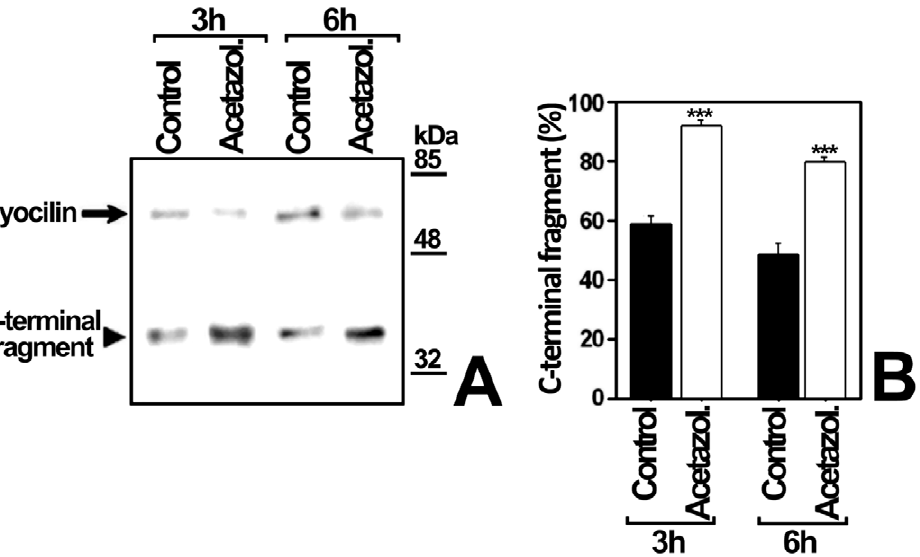
Figure 8. Effect of carbonic anhydrase inhibition on myocilin proteolytic processing. (A) HEK-293T cells (500000 cells/plate) were transfected with a cDNA construct encoding myocilin-myc. After transfection cells were cultured in bicarbonate-free HEPES buffered medium (75 mM, pH 7.1) for 3 or 6 h in the presence of acetazolamide (0.25 mM). Extracellular recombinant myocilin was analyzed by 10% polyacrylamide SDS-PAGE and Western blot using an anti-myc monoclonal antibody. Equal amount of total protein was loaded into each well. (B) Quantitation by densitometry of the C-terminal fragment detected in A. Values represent the proportion of this myocilin fragment, expressed as indicated in Fig. 1B. Error bars correspond to the SD of two independent experiments carried out in triplicate. Asterisks indicate one-way ANOVA statistical significance compared to control: p , 0.001 (***).